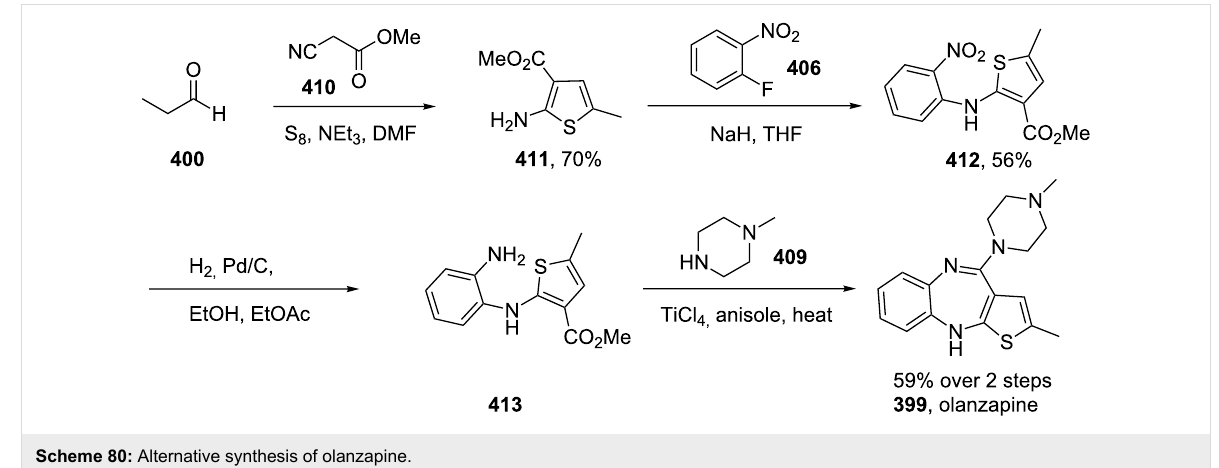
Scheme 80: Alternative synthesis of olanzapine.